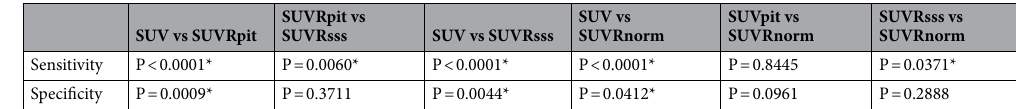
Table 8. McNemar’s Test Results comparing the four methods at the pre-determined thresholds.